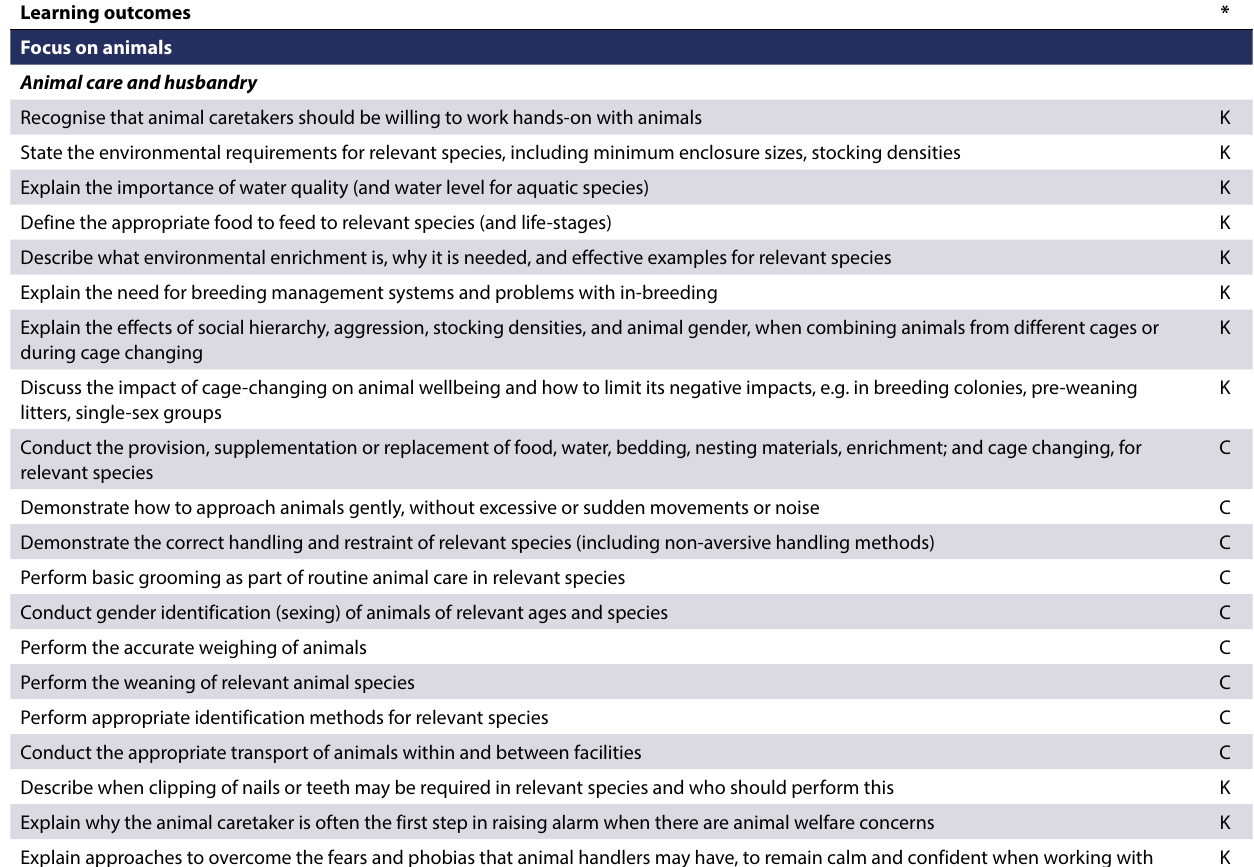
Table I: Learning outcomes for the education and training of laboratory animal caretakers in South Africa. Learning outcomes Focus on